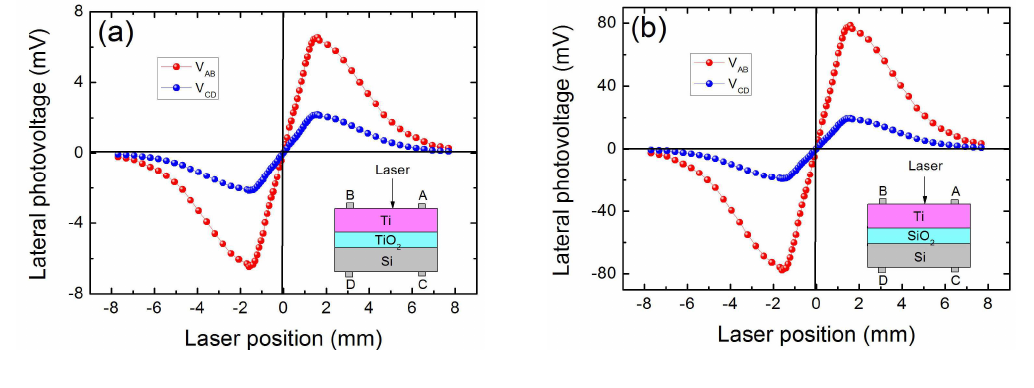
Figure 4. (a) LPV measurement on both metal and semiconductor sides in MOS structure of Ti(6.2 nm)/TiO (1.2 nm)/Si. (b) LPV measurement on both metal and semiconductor 2 (1.2 nm)/Si. Here the contacts’ sides in MOS structure of Ti(6.2 nm)/SiO 2